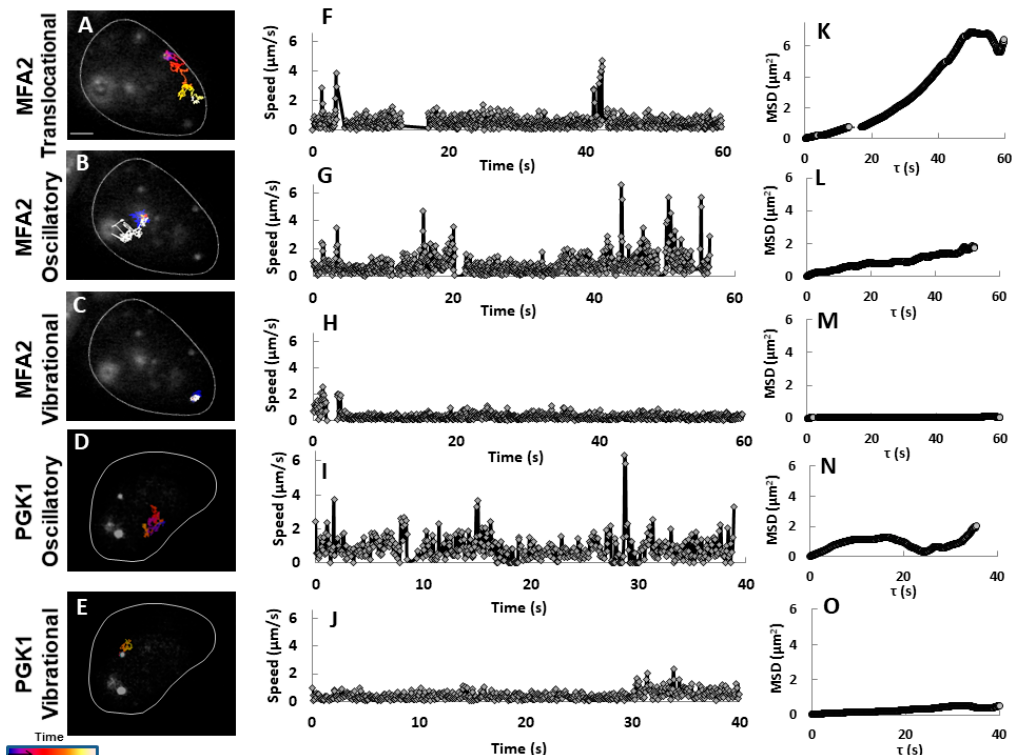
Figure 5. MSD rather that velocity distinguished the different types of movement. Three MFA2 ( A – C ) and 2 PGK1 ( D – E ) granules were tracked in yeast cells treated with pheromone for 2 h before movies were taken in 2D by fluorescence microscopy . The interval between frames was 0.055-0.07 s. Scale bar = 1.5 µm applies to ( A – E ). ( F – J ) Speed at a given time point was given as the average of the local velocities determined for three neighboring time points, where local velocity was the calculated as the distance traveled over two frames divided by one time intervals. ( K – O ) Mean Square Displacement (MSD) was diagnostic for random and nonrandom translocation as well as corralled movement.